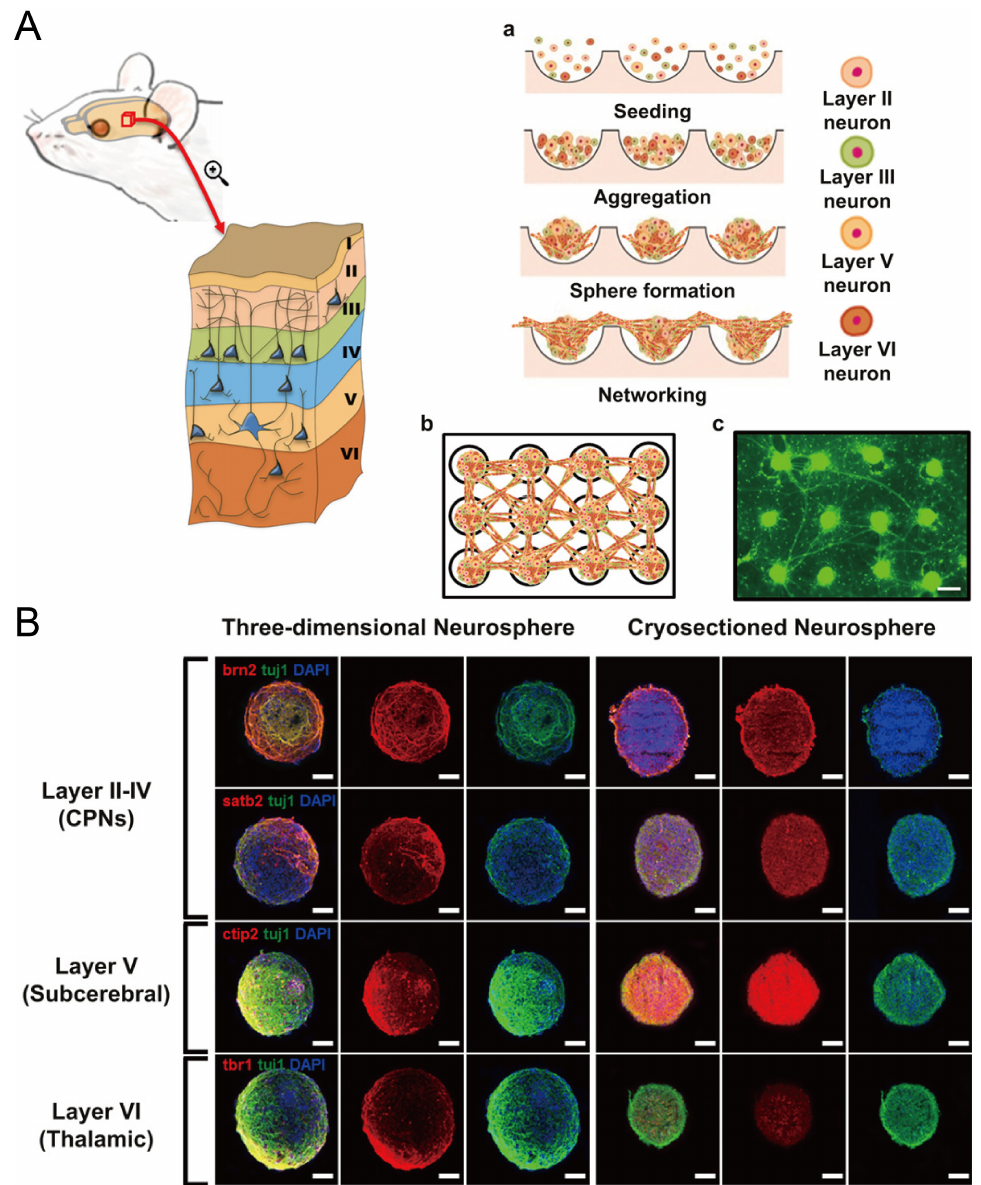
Figure 17. Formation of neurosphere and neural network [94]. ( A ) The schematic view showing the different layers of cortical region of prenatal rat (left), the procedures of neurosphere formation in concave microwells (right: a), the schematic of the network of neurospheres (right: b), and the pictures of neurospheres stained with calcein AM (right: c). Scale bar: 300 µm. ( B ) Fluorescent pictures of three-dimensional neurosphere and cryosectioned neurosphere stained against various transcription factors. Different transcription factors are specific to different layers of the cortical region: Brn2 and Satb2 corresponded to layers II-IV, CTIP2 corresponded to layer V, and Tbr1 corresponded to layer VI. Scale bar: 100 µm. Reprinted (adapted) from [94]. Copyright (2013) with permission from